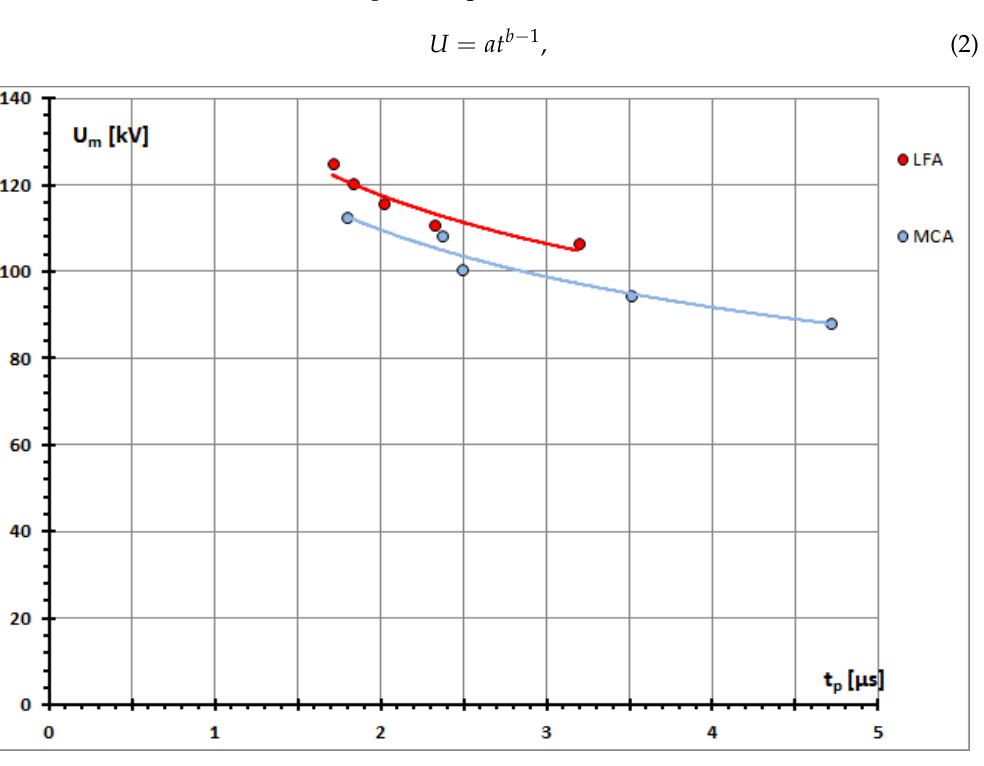
Figure 12. Comparison of voltage–time characteristics for the MCA and the LFA for negative